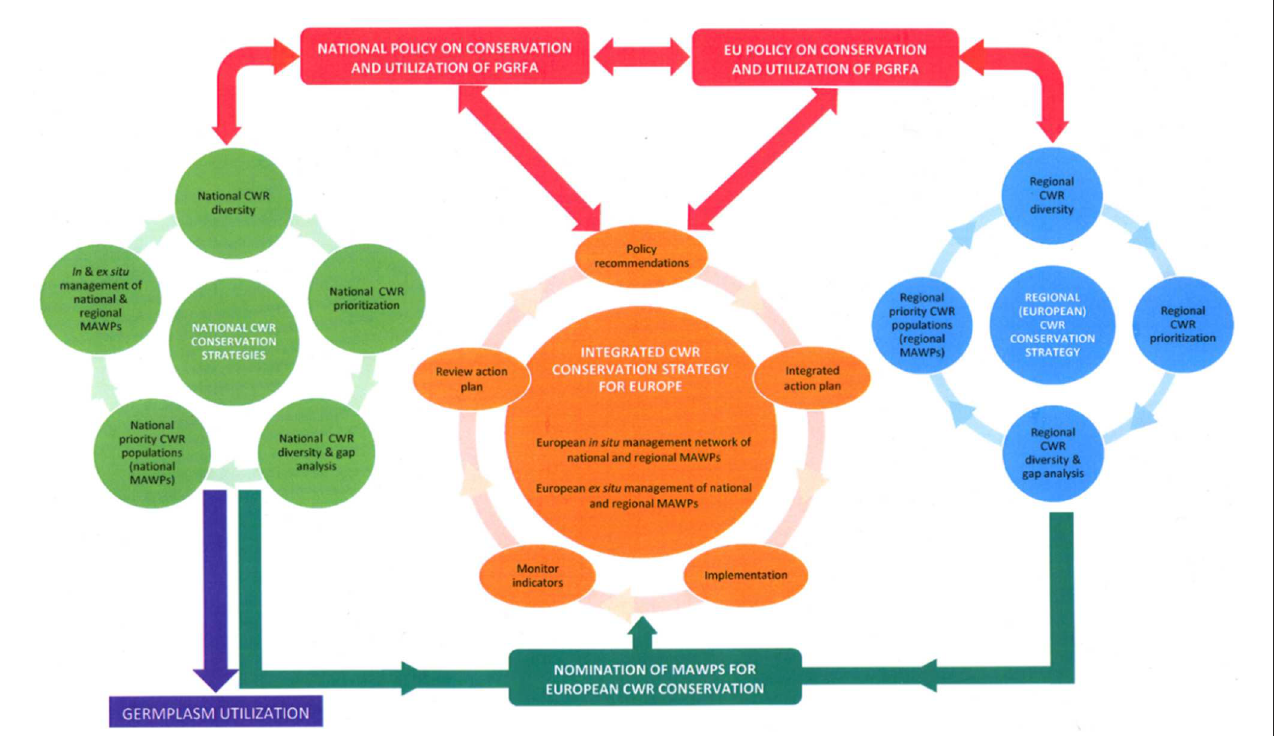
FIGURE4 Integration of CWR populations from national and regional networks in one integrated in situ network (Maxted et al.,